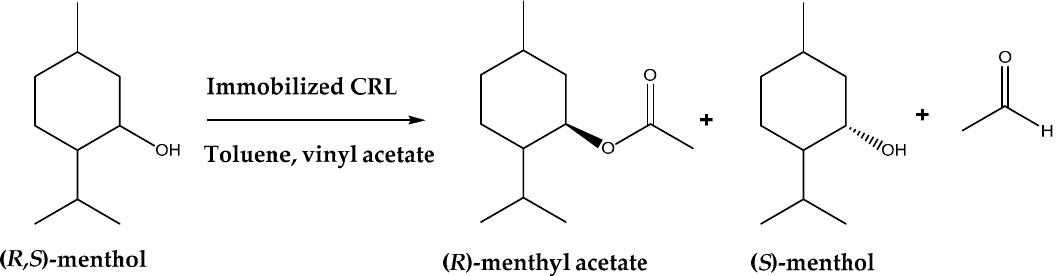
Figure 15. Kinetic resolution of ( R , S )-menthol with vinyl acetate catalyzed by CRL immobilized in starch films by entrapment.